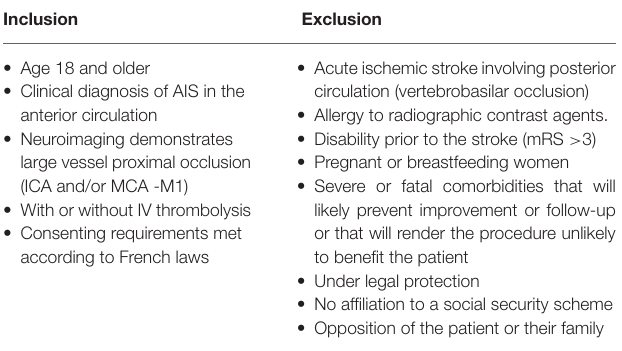
TABLE 2 | Inclusion and exclusion